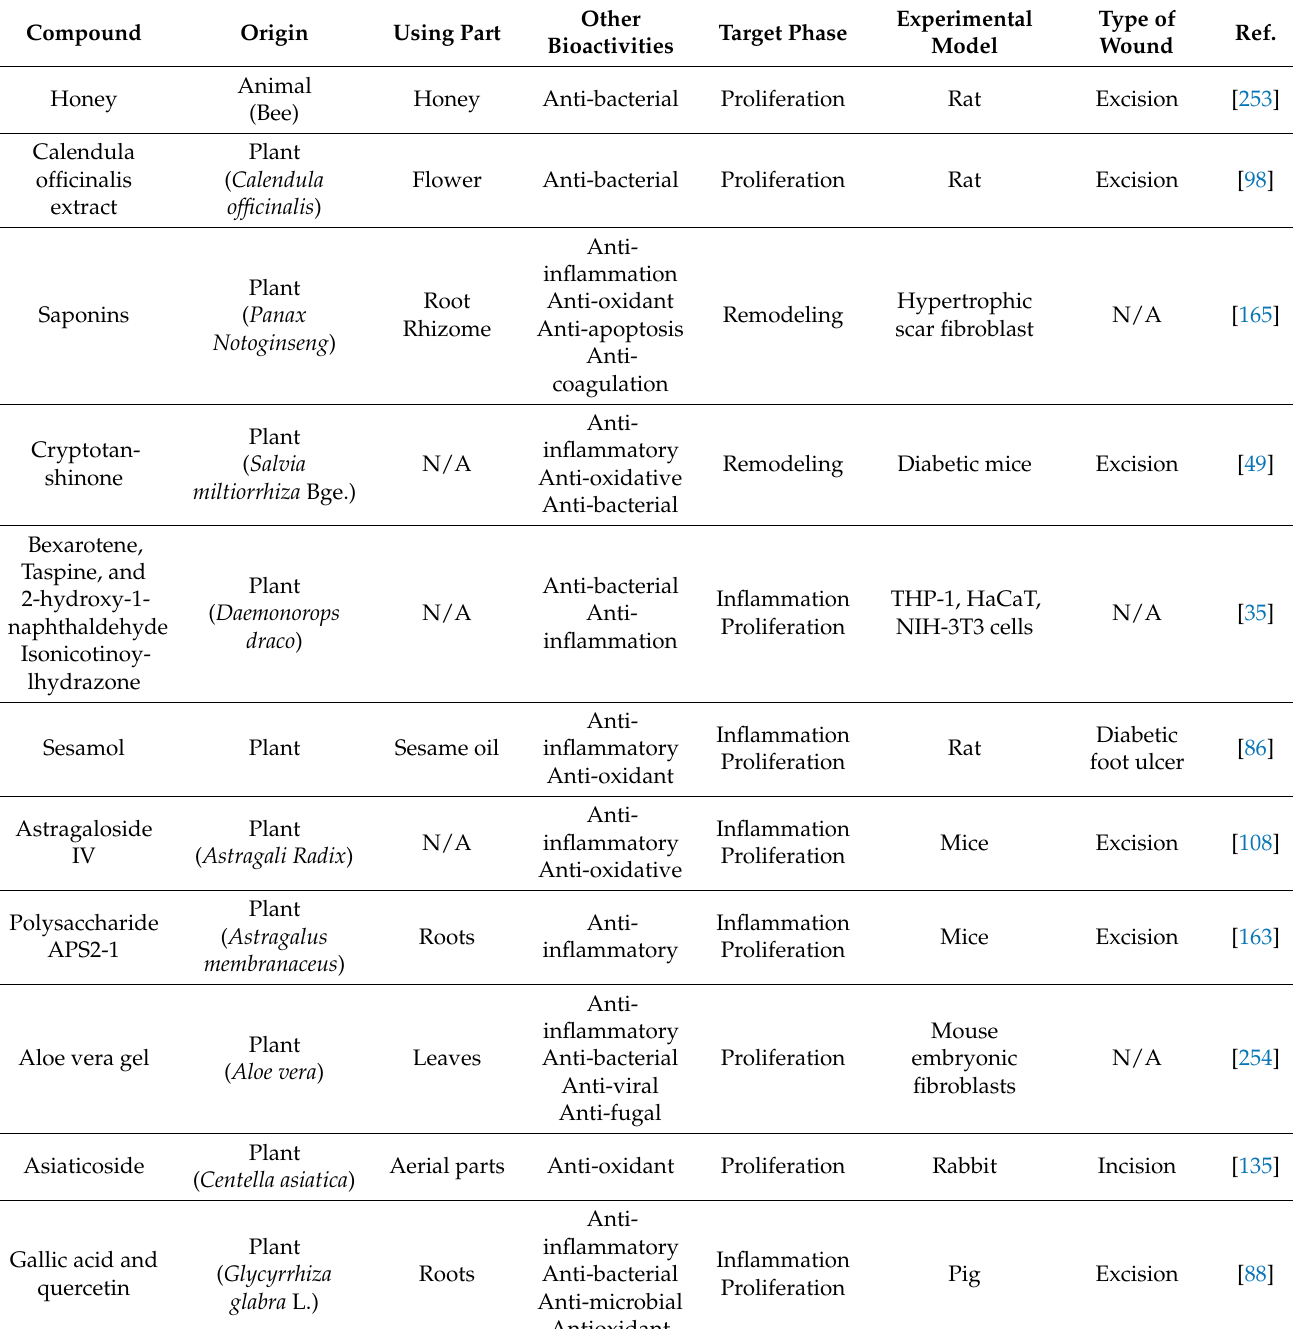
Table 4. Compounds with collagen